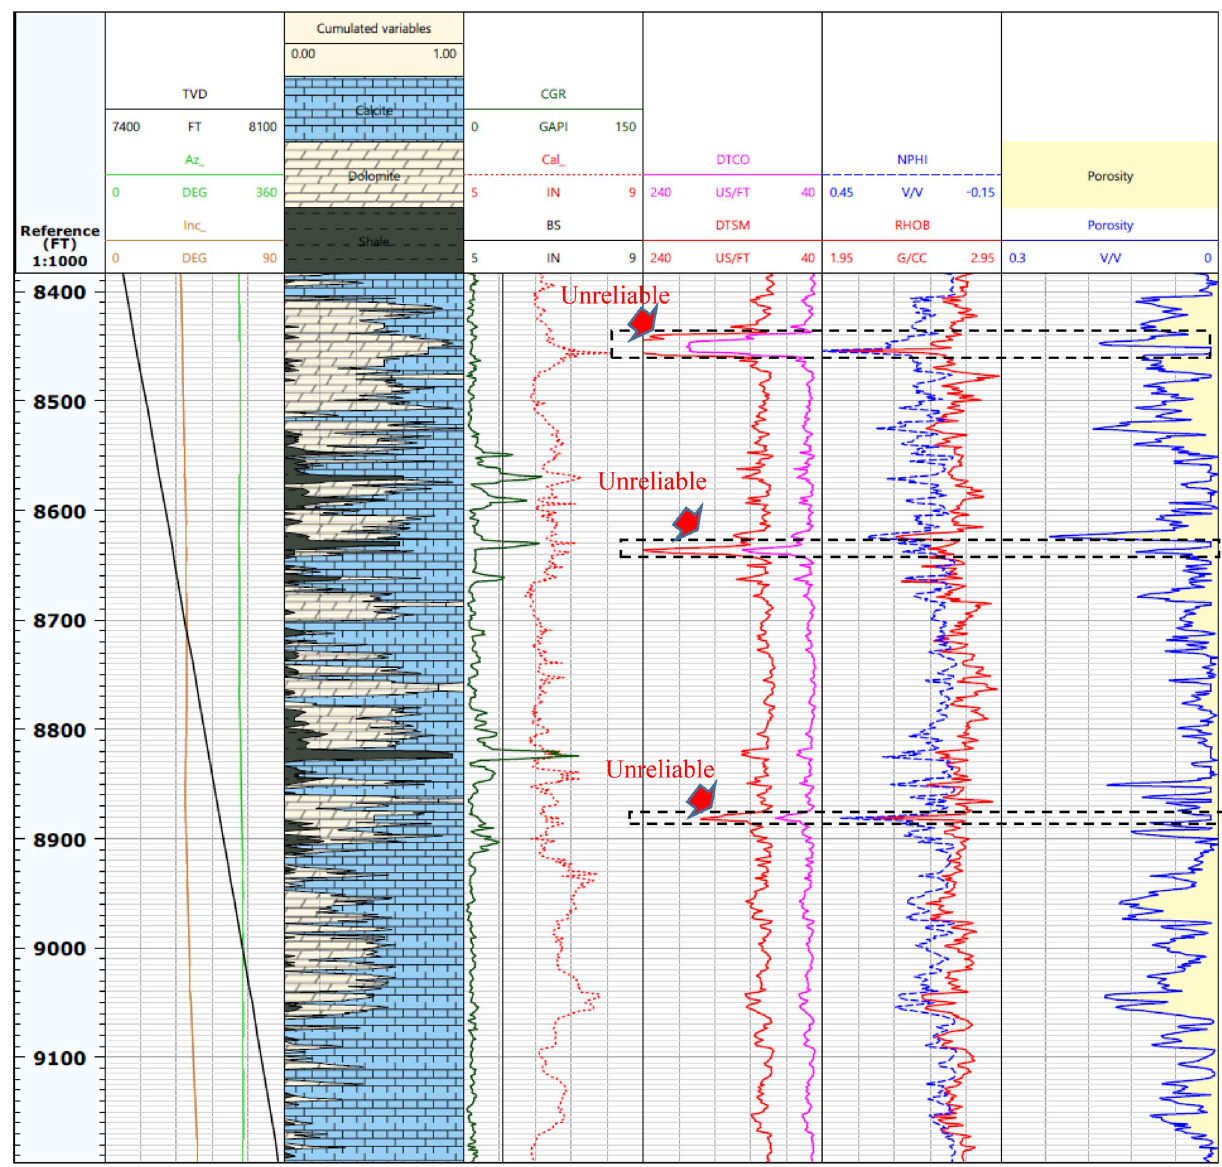
Fig. 2 Petrophysical well logs for the well under study, including interpreted lithology and porosity required for estimation of rock moduli, strength and pore compressibility of the formation for the interval 8383–9187 ft (2555–2800 m). Due to some zones with exces- sive washout of the wellbore, which can be observed by compar- ing the caliper and the hole size, log measurements for these zones could not be corrected and are unreliable. Legend: TVD, true verti-